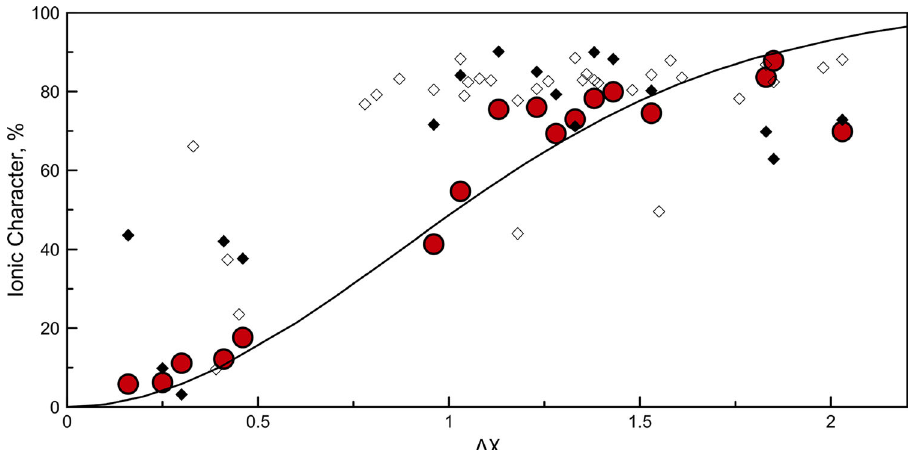
Fig. 3 Ionic character in diatomic molecules. Bond ionic character (IC) for different compounds calculated from dipole moment (i.e., red circles) and Bader charges for molecules (i.e., fi lled diamonds) and crystals (i.e., open diamonds) vs electronegativity difference